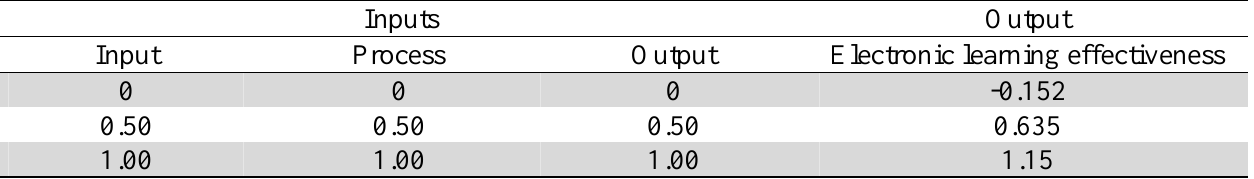
The summary of changes on input/output